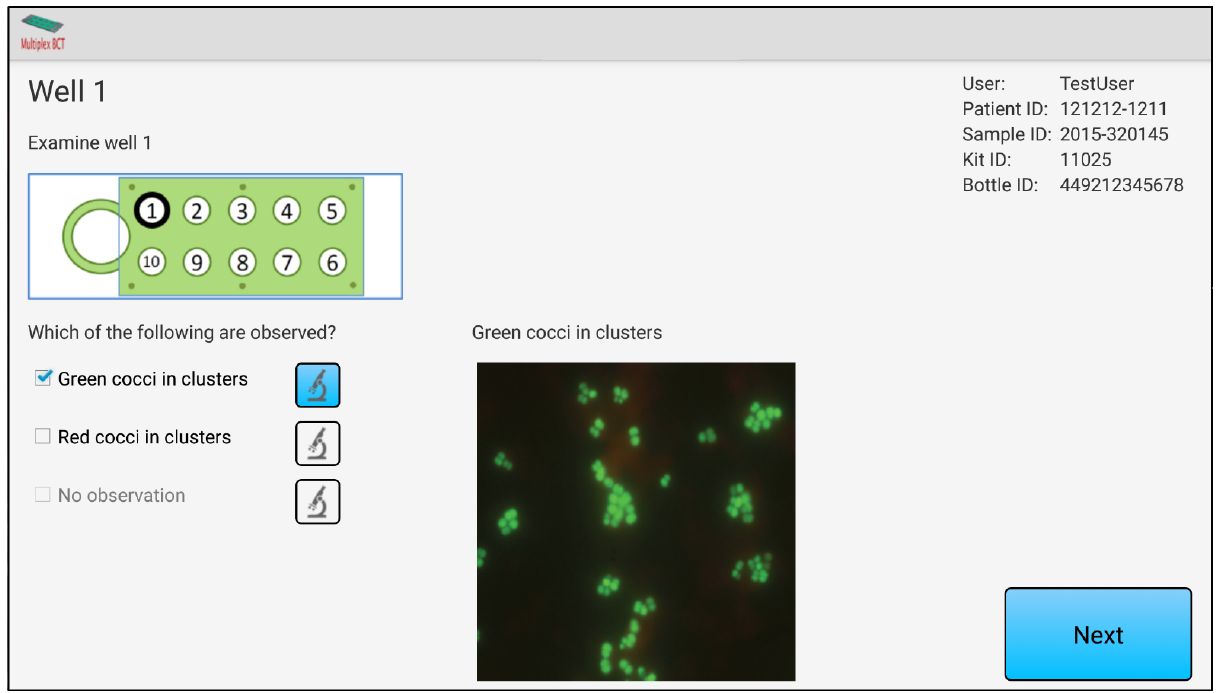
Figure 2. Sample screenshot of the Multiplex Blood Culture Test (MuxBCT) app showing data entry of test results acquired through fluorescence microscopy of the MuxBCT diagnostic test. The patient information displayed in the image is